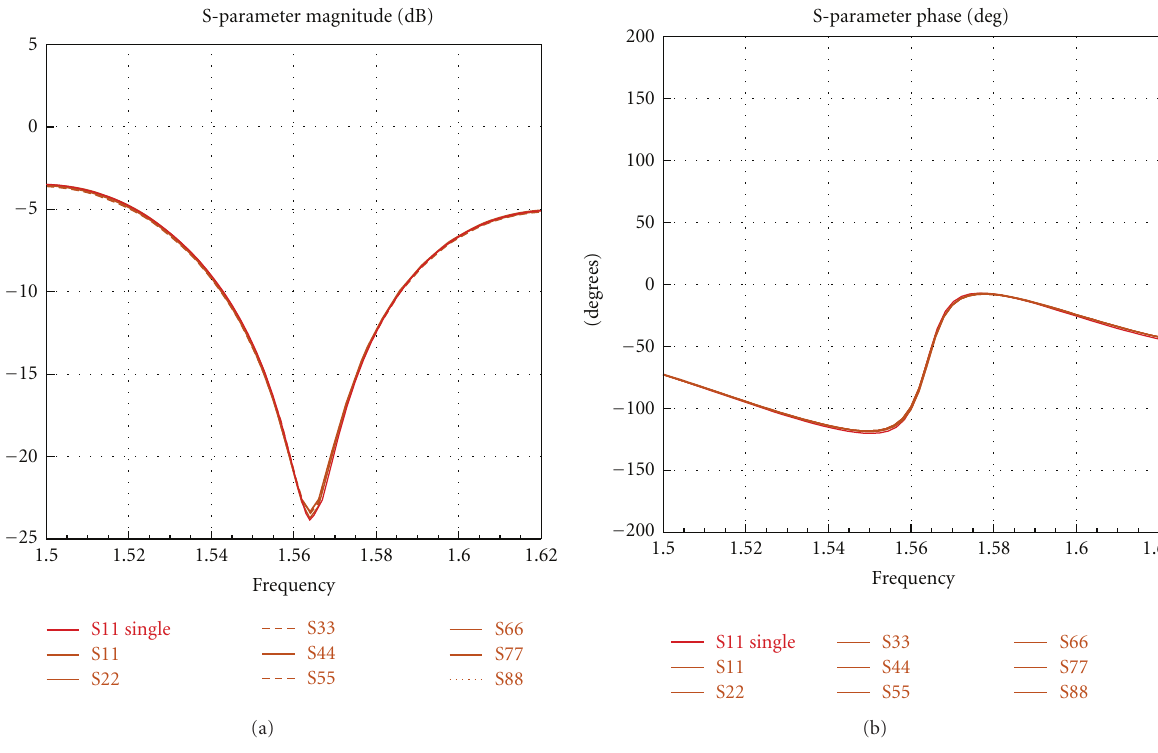
Figure 5: Mutual coupling e ff ects over the array elements: (a) magnitude (dB) and (b) phase